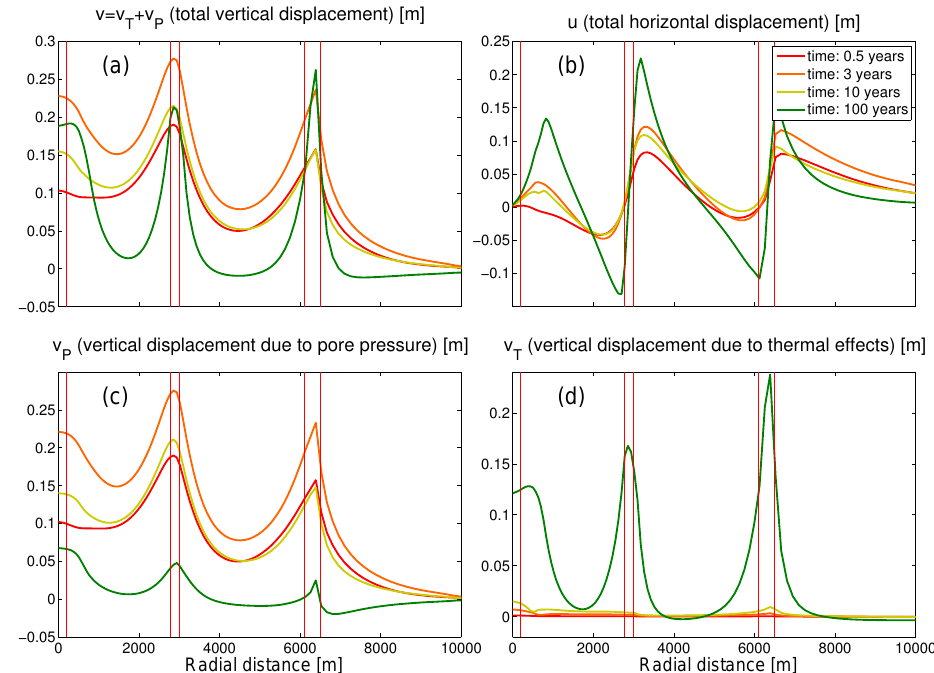
Figure 10. Ground deformation computed for Scenario III at the surface after t = 0 . 5, 3, 10 and 100 years of unrest: total vertical deformation (a) , total horizontal deformation (b) , vertical deformation due to pore pressure (c) , and vertical deformation due to thermal effects (d) . Vertical lines refer to the boundary of the central conduit and to the injection and shallowest points of faults.